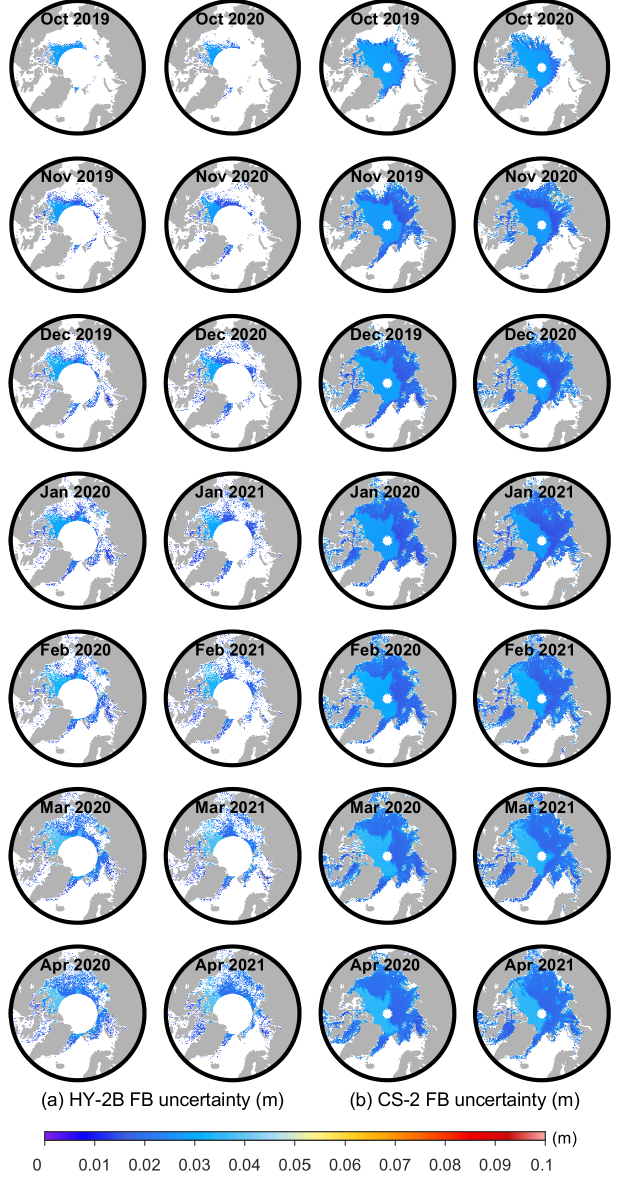
Figure 12. Monthly comparisons between HY-2B sea ice thickness uncertainties and CS-2 sea ice thickness uncertainties from October (a) shows the HY-2B sea ice thickness uncertainties, and panel (b) shows the CS-2 sea ice thickness